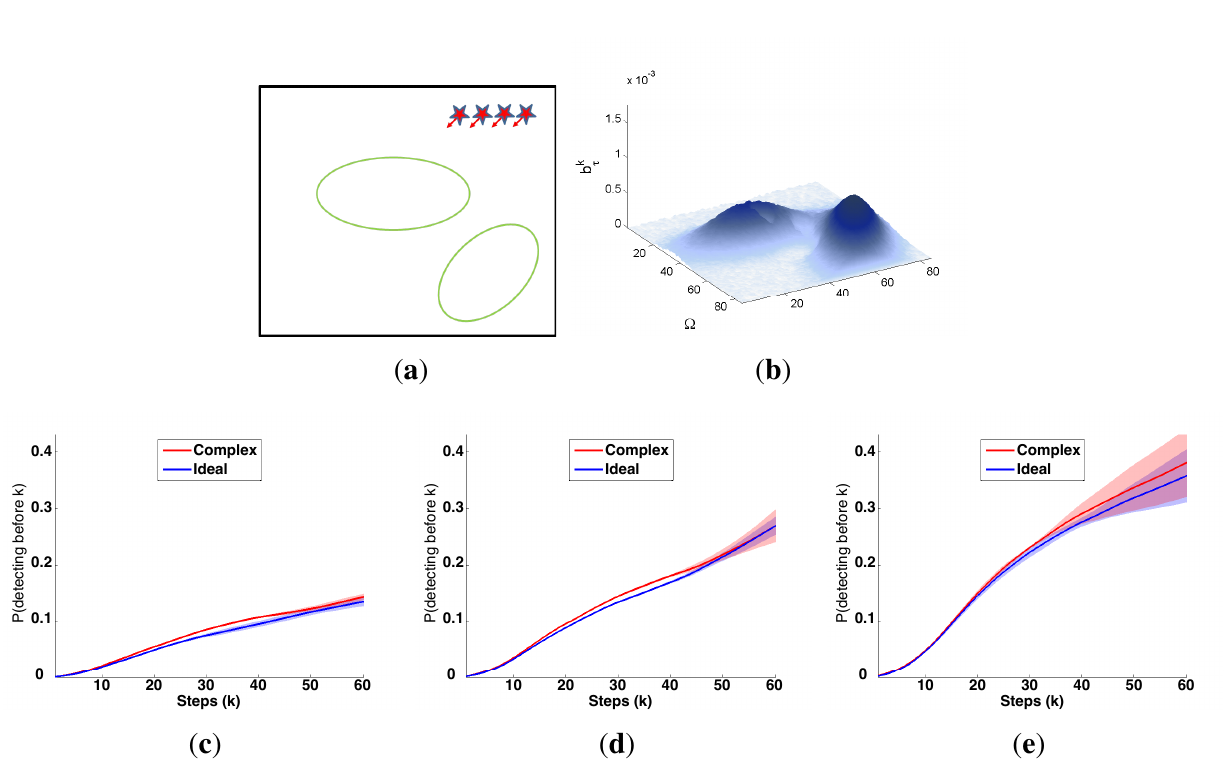
Figure 5. Properties and Information Gain (IG) curves of the static scenario of the radar experimental setup. ( a ) Schema; ( b ) Initial belief b ( τ 0 ) ; ( c ) IG, M = 1 ; ( d ) IG, M = 2 ; ( e ) IG, M = 4